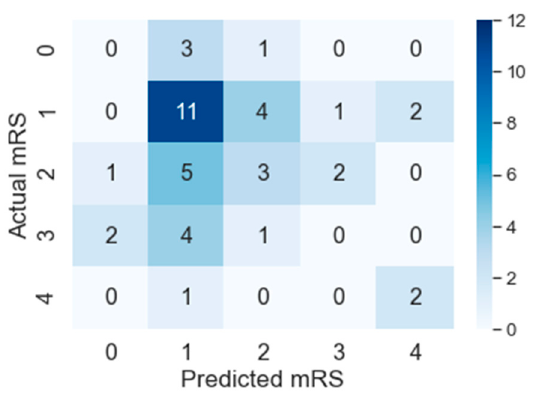
Figure 7. Confusion matrix of PMFE-SN on leave one cross out testing. Table 2. Comparison of MAE M of state-of-the-art and PMFE-SN on leave one cross out testing. Method Cases from ISLES 2017 Random Forest for Stroke Lesion and